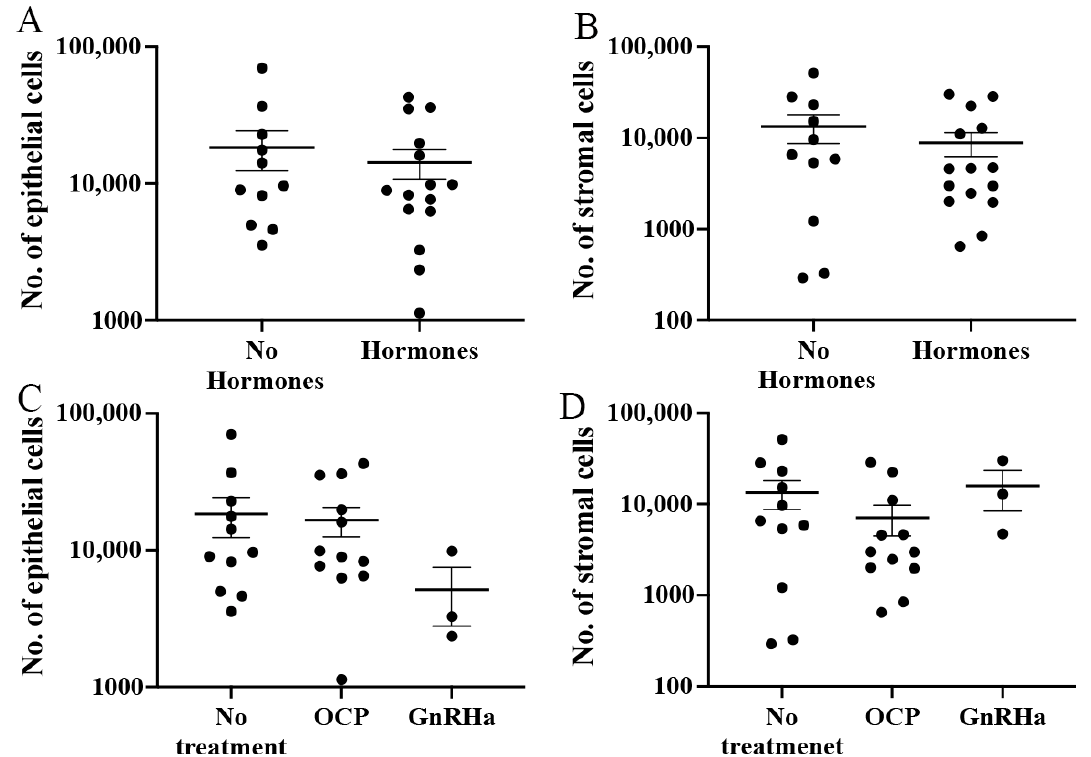
Figure 6. Relationship between cell numbers and hormonal treatment. A comparison between the number of ( A ) epithelial and ( B ) stromal cells found in samples derived from women who were not using hormonal treatments and women who were using hormonal treatments. Stratification of hormonal treatments via OCP and GnRHa did not show any significant difference in either ( C ) epithelial cells or ( D ) stromal cells.